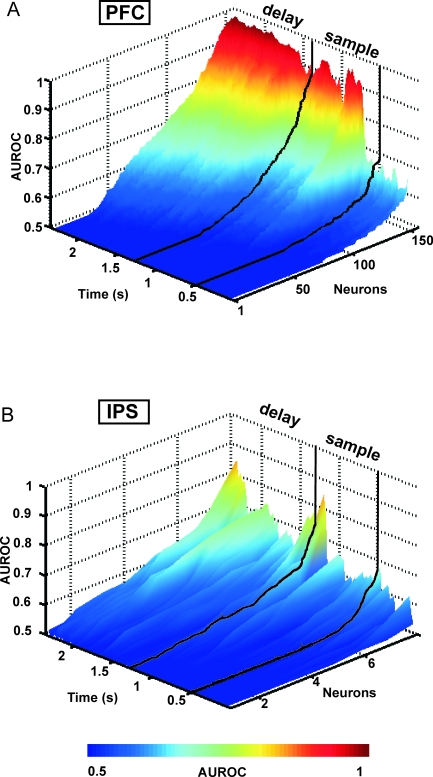
Time Course of Association StrengthThe association strength (measured as the AUROC) of 157 association PFC (A) and eight association IPS (B) neurons. AUROC values were sorted independently for each time bin. Higher AUROC values indicate stronger association, i.e., more similar tuning functions to the dot and shape protocols. Black lines correspond (from right to left) to sample onset and offset. Time is aligned to the midpoint of the sliding windows.